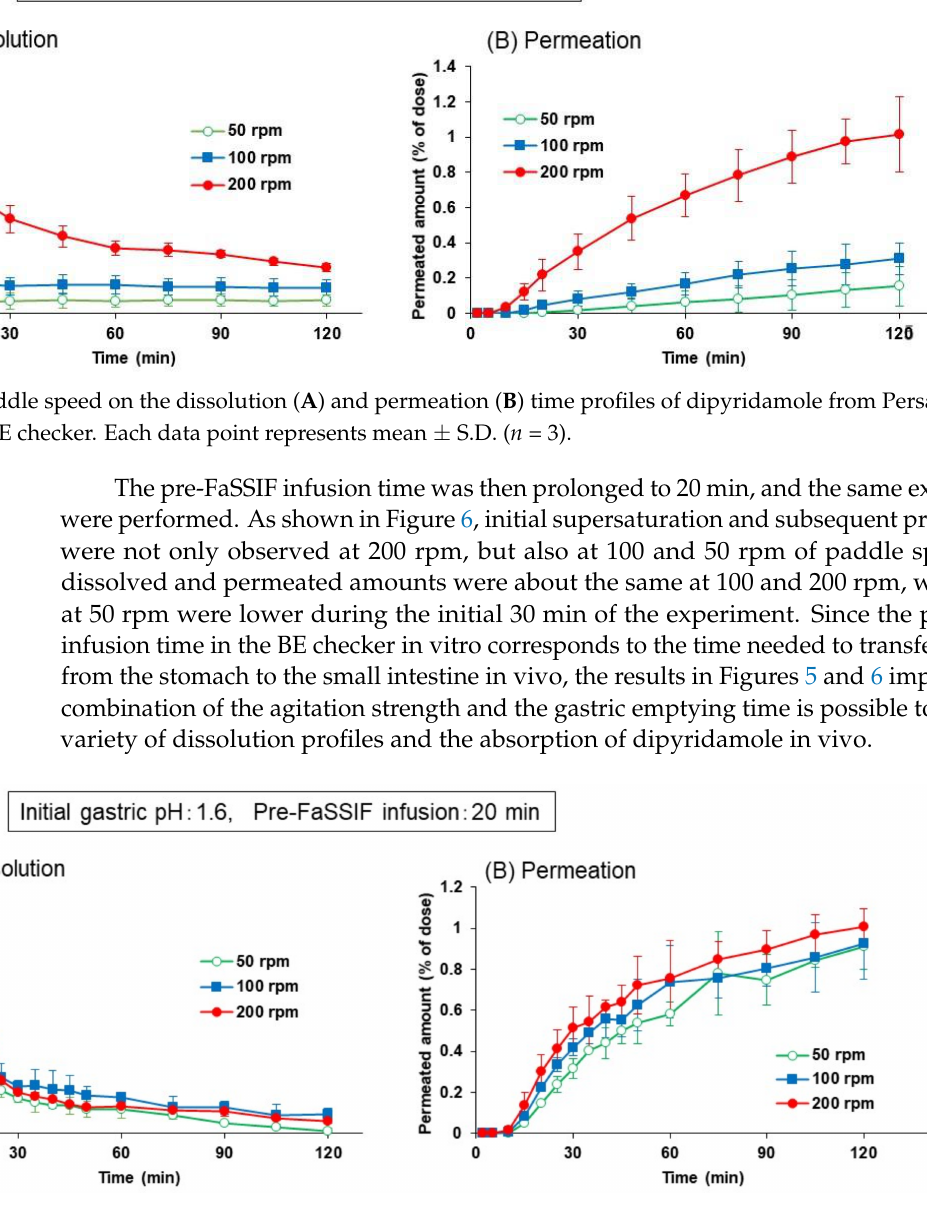
Figure 6. Effect of pre-FaSSIF infusion time on the dissolution ( A ) and permeation ( B ) time profiles of dipyridamole from Persantin ® tablets 25 mg in the BE checker. Each data point represents mean ± S.D. ( n =